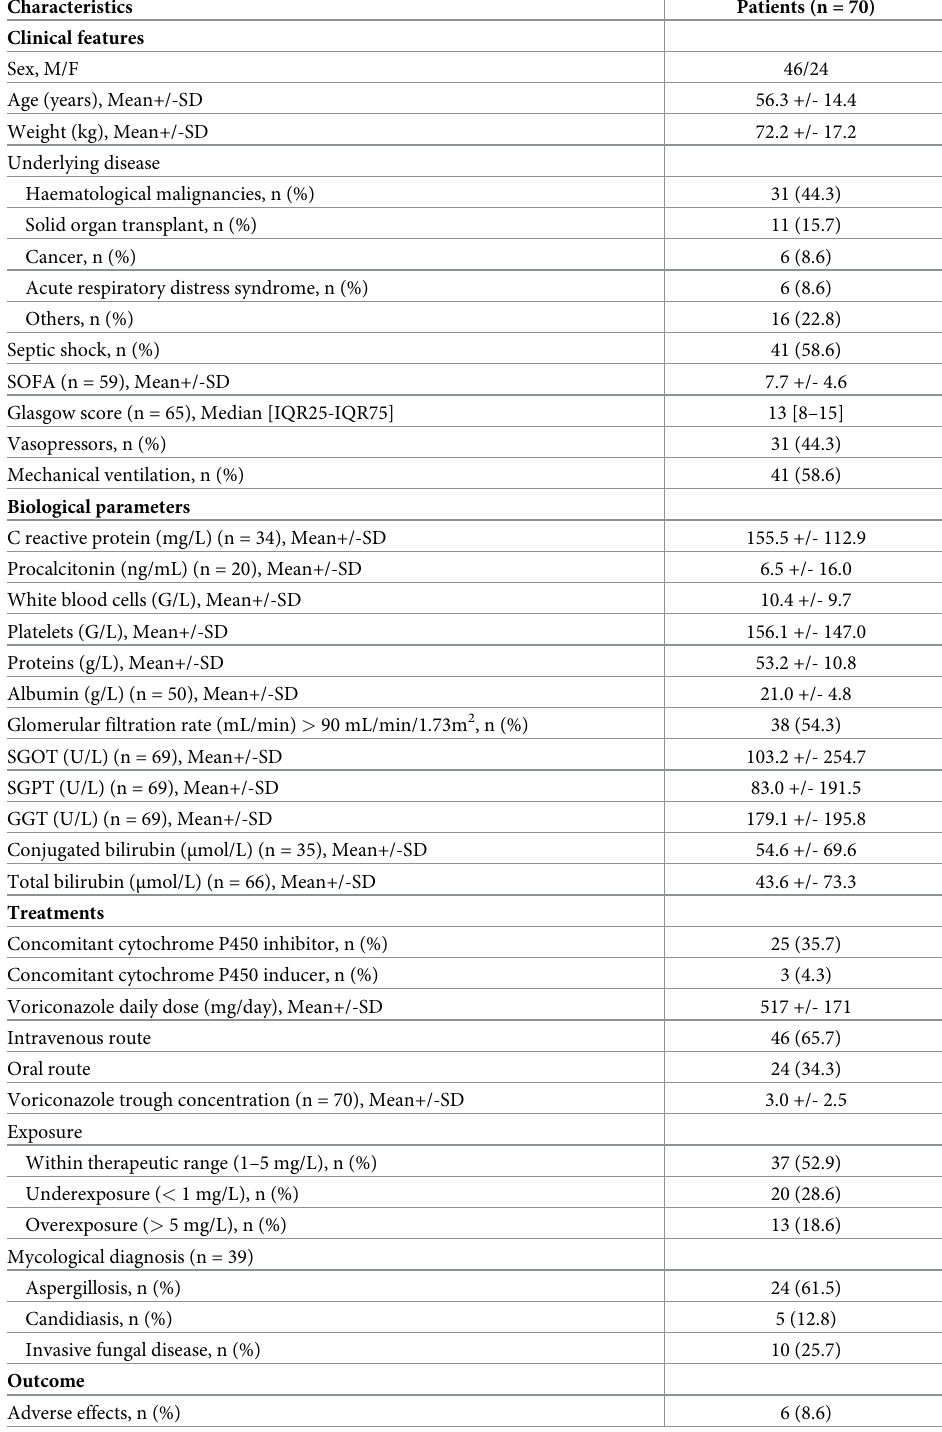
Table 1. Baseline characteristics of critically ill patients on the first voriconazole therapeutic drug monitoring. Data presented are means +/- standard deviations or numbers and corresponding percentages